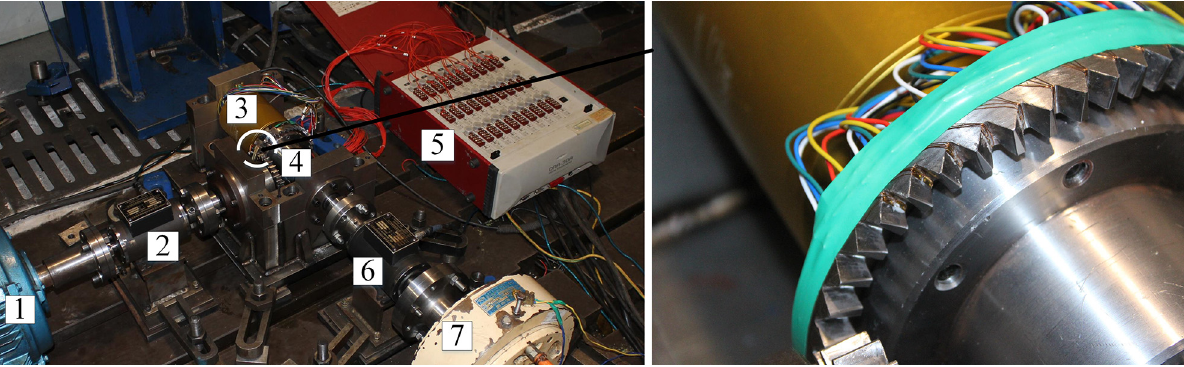
Fig. 17. Measurement of tooth root bending stress.